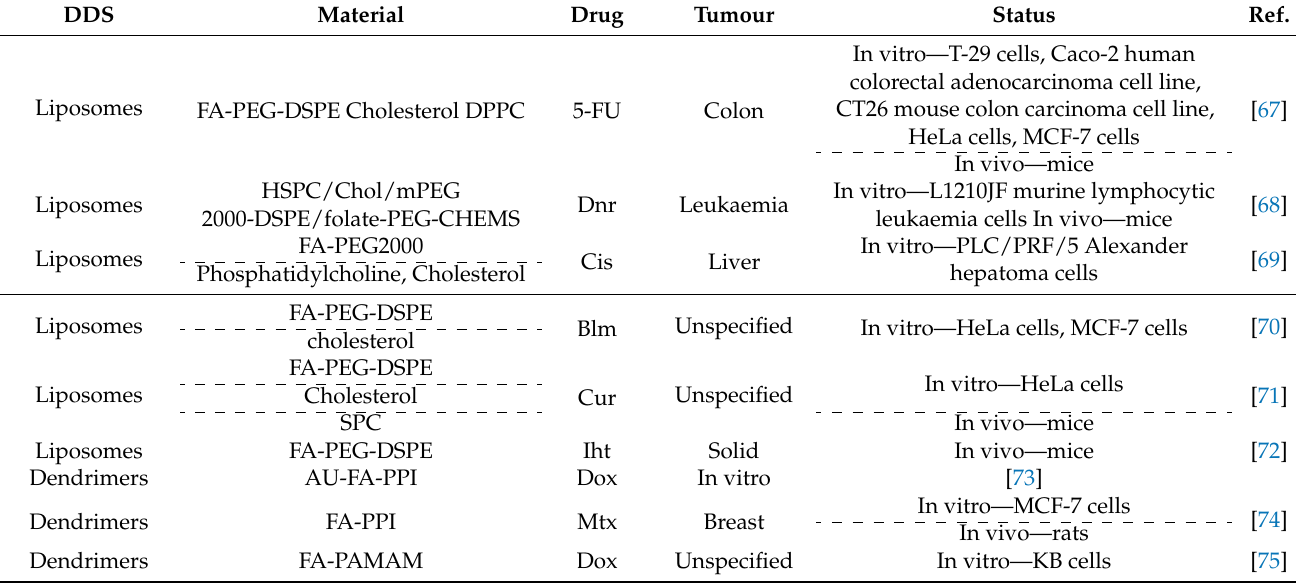
Table 1. The examples of various FA-targeted nanoparticles for anticancer